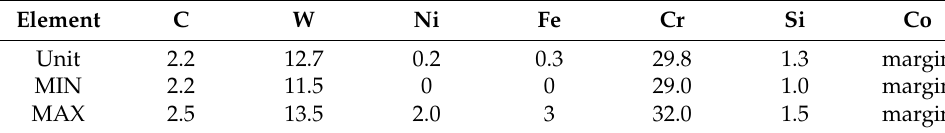
Table 1. Chemical composition of Co-Cr based powder (Quality Score %).